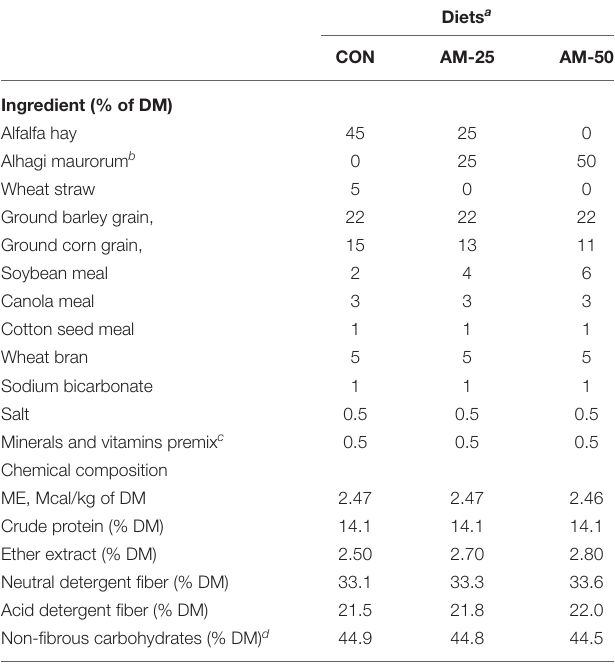
TABLE 1 | Ingredients and nutrient composition [dry matter (DM) basis] of experimental diets.